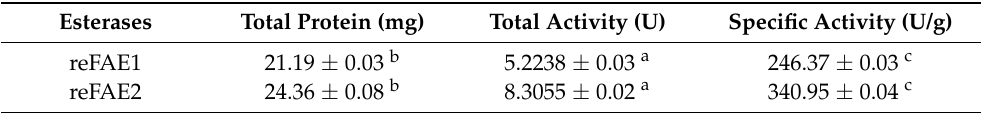
Table 1. Results of purification of recombinases.